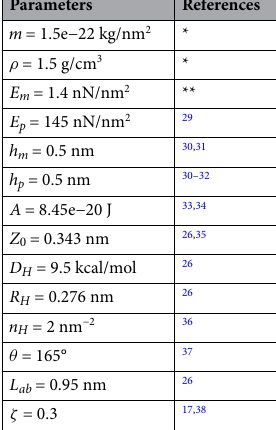
where (cid:31) h 1 and (cid:31) h 3 are the current deformations of the particle and matrix elastic elements above the mass, respectively, and (cid:31) h 2 and (cid:31) h 4 are the current deformations of the particle and matrix elastic elements below the mass, respectively.